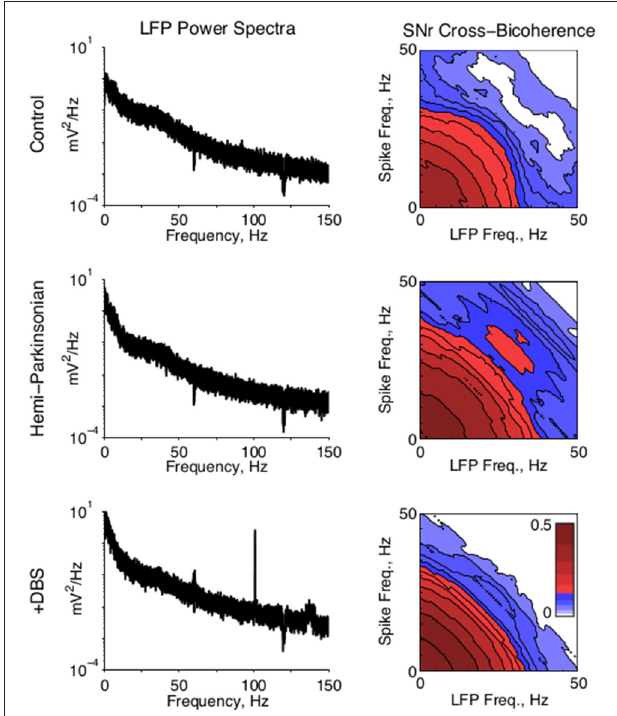
FIGURE 4 | Local field potential activity . (Left) Representative LFP power spectra from SNr in all conditions. A strong 100 Hz peak in the STN-DBS condition reflects the stimulation frequency. (Right) Population average of the cross bicoherence between the unit activity and LFPs recorded on the same electrode in SNr, for all conditions. A prominent peak indicates strong beta-beta bicoherence centered at ∼ 28 Hz in both unit and LFP frequency. Cross bicoherence at higher frequencies was generally elevated in hPD condition relative to control, suggesting stronger spike entrainment to higher frequency synaptic activity; and generally suppressed in the STN-DBS condition relative to hPD and control, suggesting relative independence of spiking from higher frequency synaptic